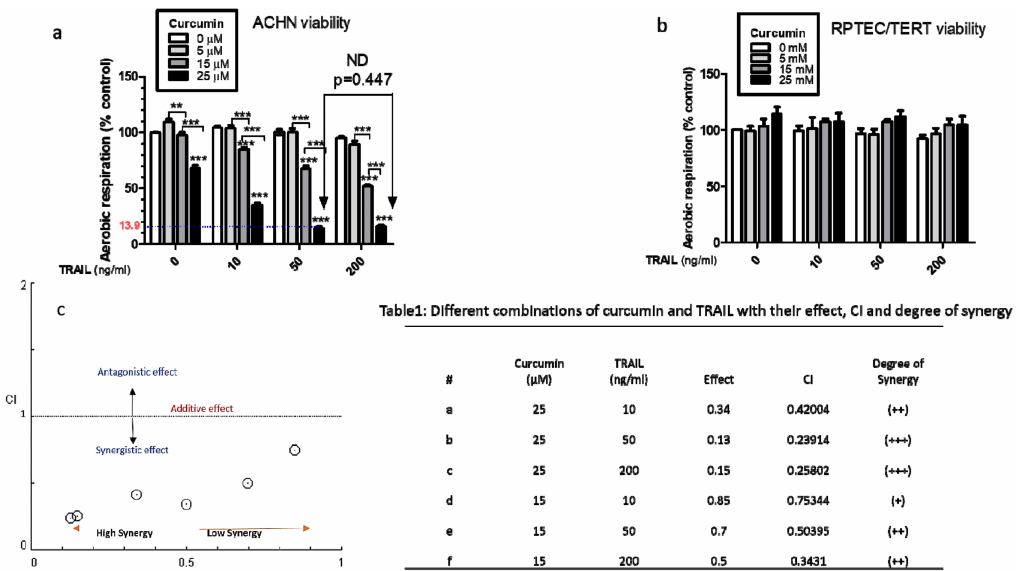
Figure 2. E ff ects of curcumin on cellular viability of cancerous ACHN and normal epithelial RPTEC / TERT1 cells. Cell viability was assessed in both ( a ) cancerous ACHN cells cultured for 24 h before treatment and ( b ) RPTEC / TERT1 cells cultured and treated 10 days post-confluency. Both cell lines were treated with curcumin (0, 5, 15 or 25 µ M) for 4 h before exposure to TRAIL (0, 10, 50 or 200 ng / mL) until 24 h. Cell viability was assessed using the FluoroFire-Blue ProViaTox Resazurin Fluorescent assay, with the results expressed as the mean resorufin fluorescence (% of control) ± SEM of three independent experiments. ** and *** indicate statistically significant di ff erence at p < 0.01 and p < 0.001, respectively. Two-way ANOVA was used to analyse the data ( c ) combination index blot and data show the interactions between TRAIL and curcumin based on medium or 50% e ff ect level. The line indicates an additive e ff ect, whereas values below are synergistic and the above are antagonistic. The degree of synergy is determined based on the calculated e ff ect by CompuSyn software; less than 0.5 determined to have a higher degree of synergy while low synergy can be observed above than 0.5. Accordingly, a very strong synergistic interaction can be noticed between 25 µ M curcumin with 200 or 50 ng / mL